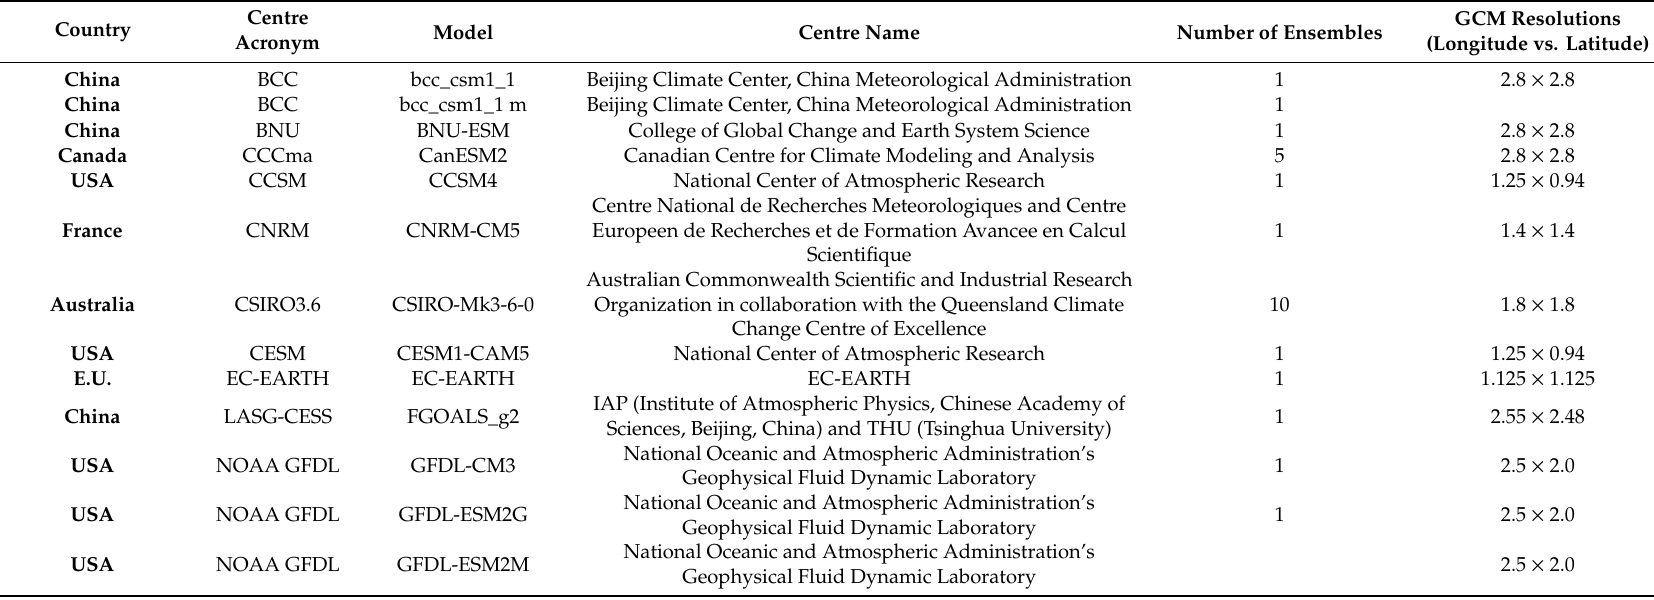
Table A2. The selected raw CMIP5 models and their attributes which has all the three emission scenarios (RCP2.6, RCP4.5 and